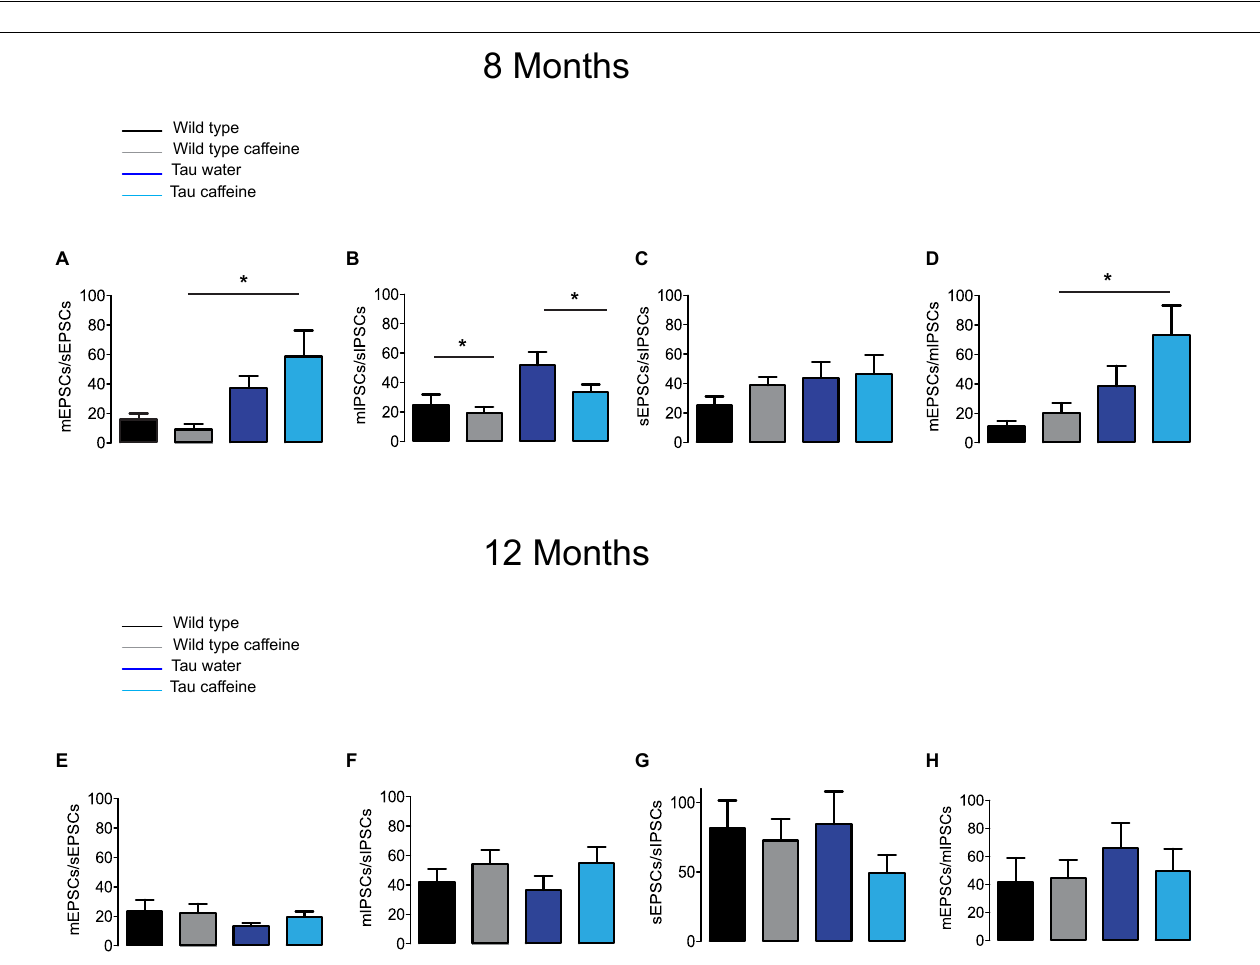
FIGURE 3 | Investigation of chronic caffeine exposure on miniature/spontaneous EPSC/IPSC ratios in 8 and 12 month-old mice. The ratios of the frequencies of mEPSCs to sEPSCs (A,E) , mIPSCs to sIPSCs (B,F) , sEPSCs to sIPSCs (C,G) and mEPSCs to mIPSCs (D,H) were analyzed for Wild type water (black), Wild type caffeine-treated (gray), Tau water (blue), and Tau caffeine-treated (light blue) 8 and 12 month-old mice. Bar graphs represent mean ± standard error; comparison between ratios was made using One way ANOVA Tukey–Kramer post doc test ( ∗ P < 0.05) n = 8 cells, 8 slices, from 5, 8 month-old Wild type water mice vs. n = 8 cells, 8 slices, from 5, 8 month-old Wild type caffeine-treated mice; n = 9 cells, 9 slices, from 5, 8 month-old Tau water mice vs. n = 9 cells, 9 slices, from 5, 8 month-old Tau caffeine-treated mice; n = 8 cells, 8 slices, from 5, 8 month-old Wild type caffeine-treated mice vs. n = 9 cells, 9 slices, from 5, 8 month-old Tau caffeine-treated mice; n = 8 cells, 8 slices, from 5, 12 month-old Wild type water mice vs. n = 8 cells, 8 slices, from 5, 12 month-old Wild type caffeine-treated mice; n = 9 cells, 9 slices, from 5, 12 month-old Tau water mice vs. n = 9 cells, 9 slices, from 5, 12 month-old Tau caffeine-treated mice; n = 8 cells, 8 slices, from 5, 12 month-old Wild type caffeine-treated mice vs. n = 9 cells, 9 slices, from 5, 12 month-old Tau caffeine-treated mice.